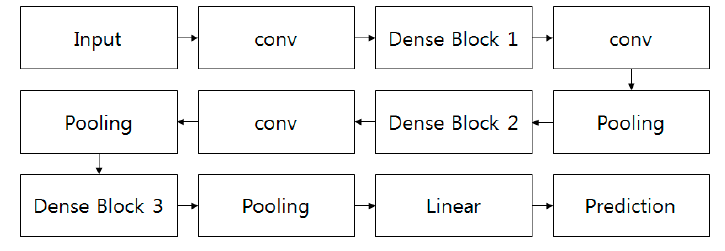
Figure 4. Structure of DenseNet.